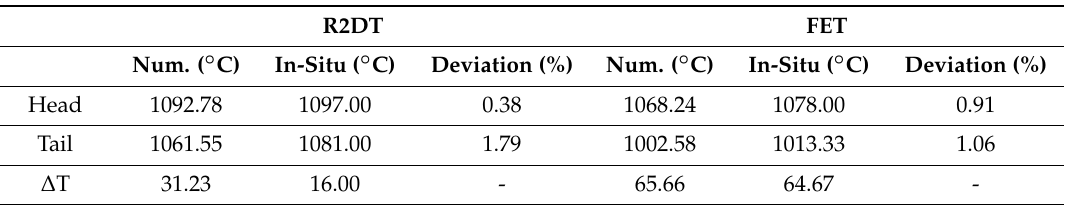
Table 2. Comparison of the numerical data with the in-situ data for the upper surface of the transfer bar with the traditional passive heat retention panel.